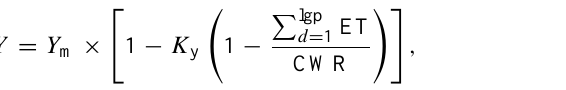
Crop coefficients Planting Growing Relative crop-growing stages K c _ini K c _mid K c _end date period L _ini L _dev L _mid L _late (days) Maize 0.70 1.20 0.25 1 Apr 150 0.20 0.27 0.33 0.20 Soybean 0.40